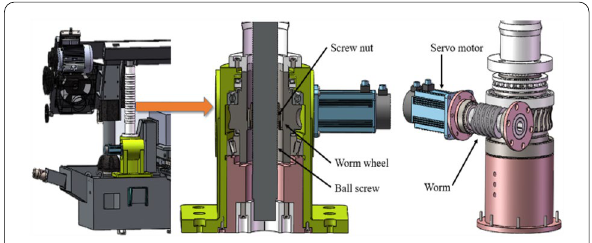
Figure 16 Servo feed device suitable for sawing